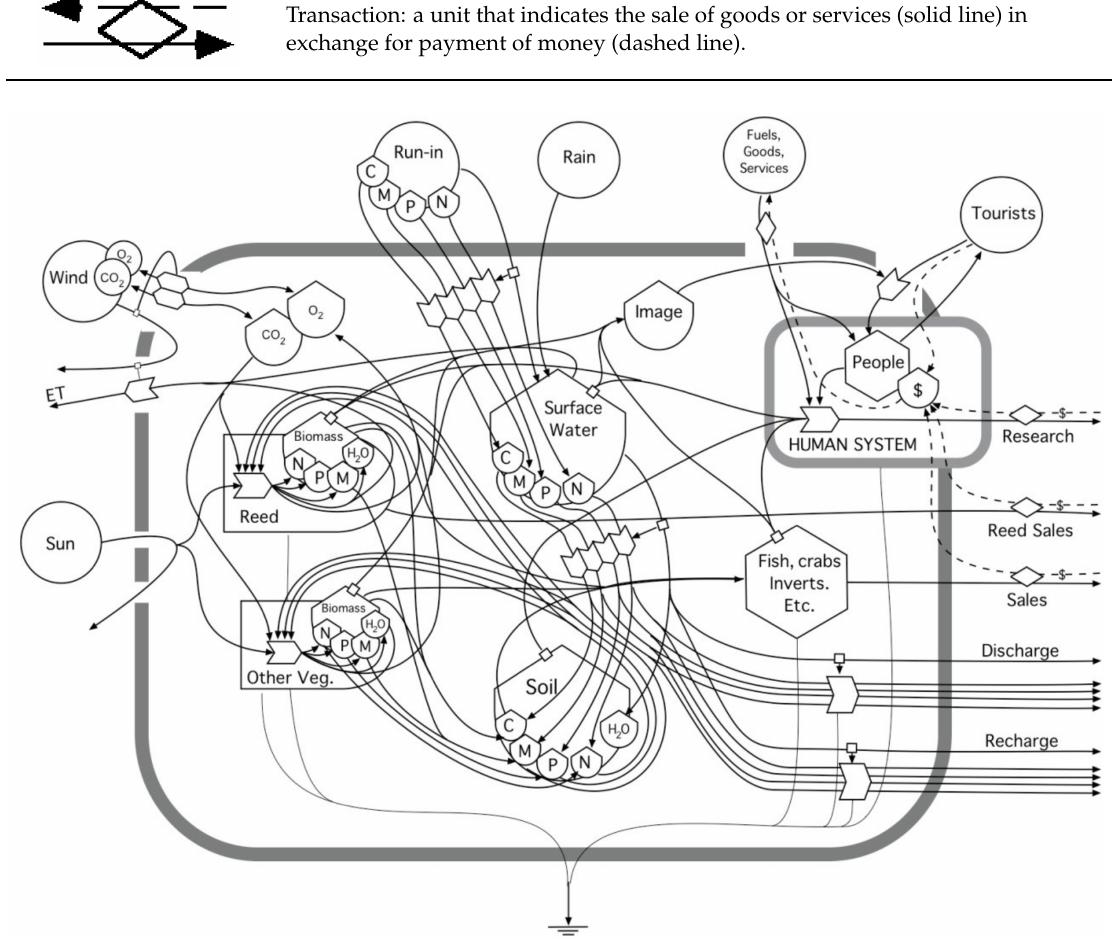
Figure 2. System diagram of the Liaohe estuarine wetland